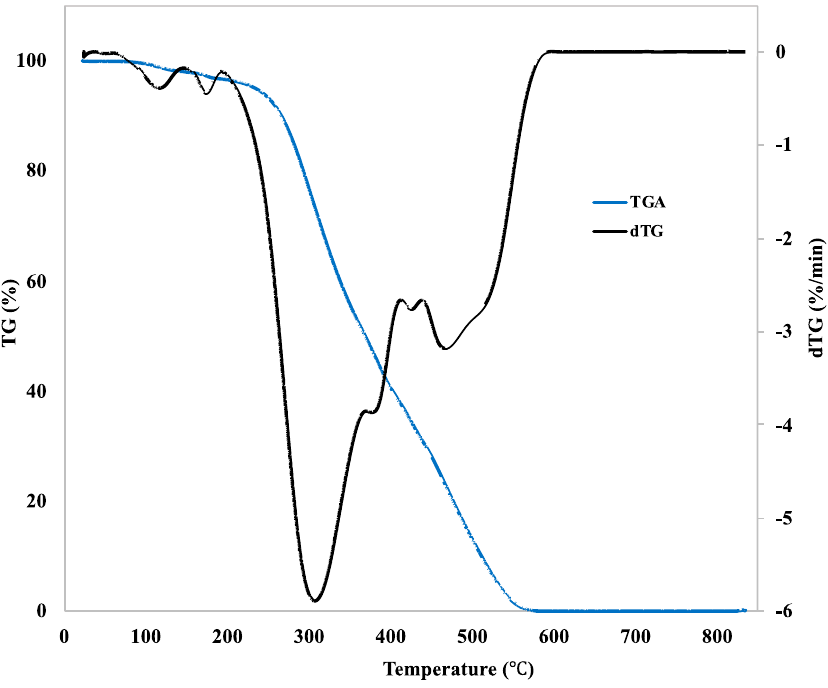
Figure 2. TGA and dTG curves of pure curcumin.